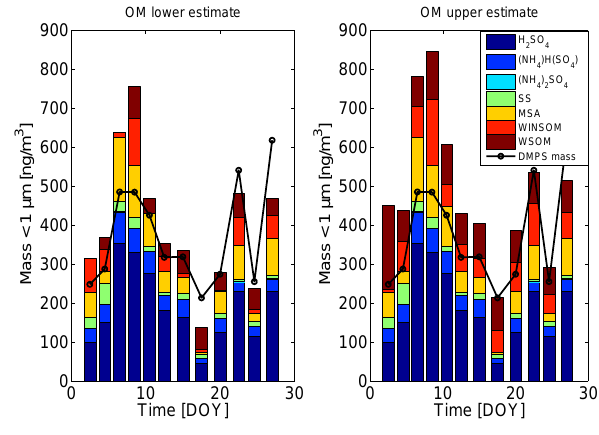
Fig. 13. Mass concentration of PM 1 (aerodynamic diameter below 1µm) as a function of time at Aboa in January 2007. Black line presents the mass calculated from the DMPS data assuming a den- sity of 1.7gcm − 3 . Coloured bars present the chemical components of the particles. Each colour corresponds to a chemical component which are: H 2 SO 4 , (NH 4 )HSO 4 , (NH 4 ) 2 SO 4 , Sea Salt (SS), MSA, Water-INSoluble Organic Matter (WINSOM) and Water-Soluble Organic Matter (WSOM). Factors 1.3 and 3.2 were used to convert from organic carbon (OC) to WINSON and WSOM, respectively. Left panel presents the lowest estimate for the OM (front filter – backup) and right panel the highest estimate for the OM (front fil- ter only). Organic material are determined from PM 1 filter samples and others from SDI-impactor